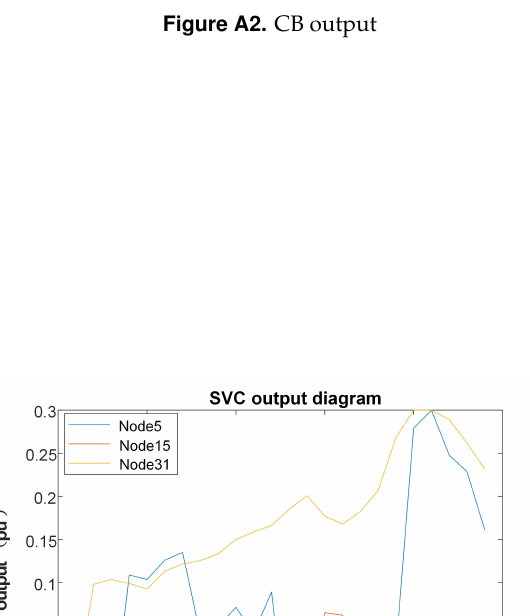
Figure A2. CB output